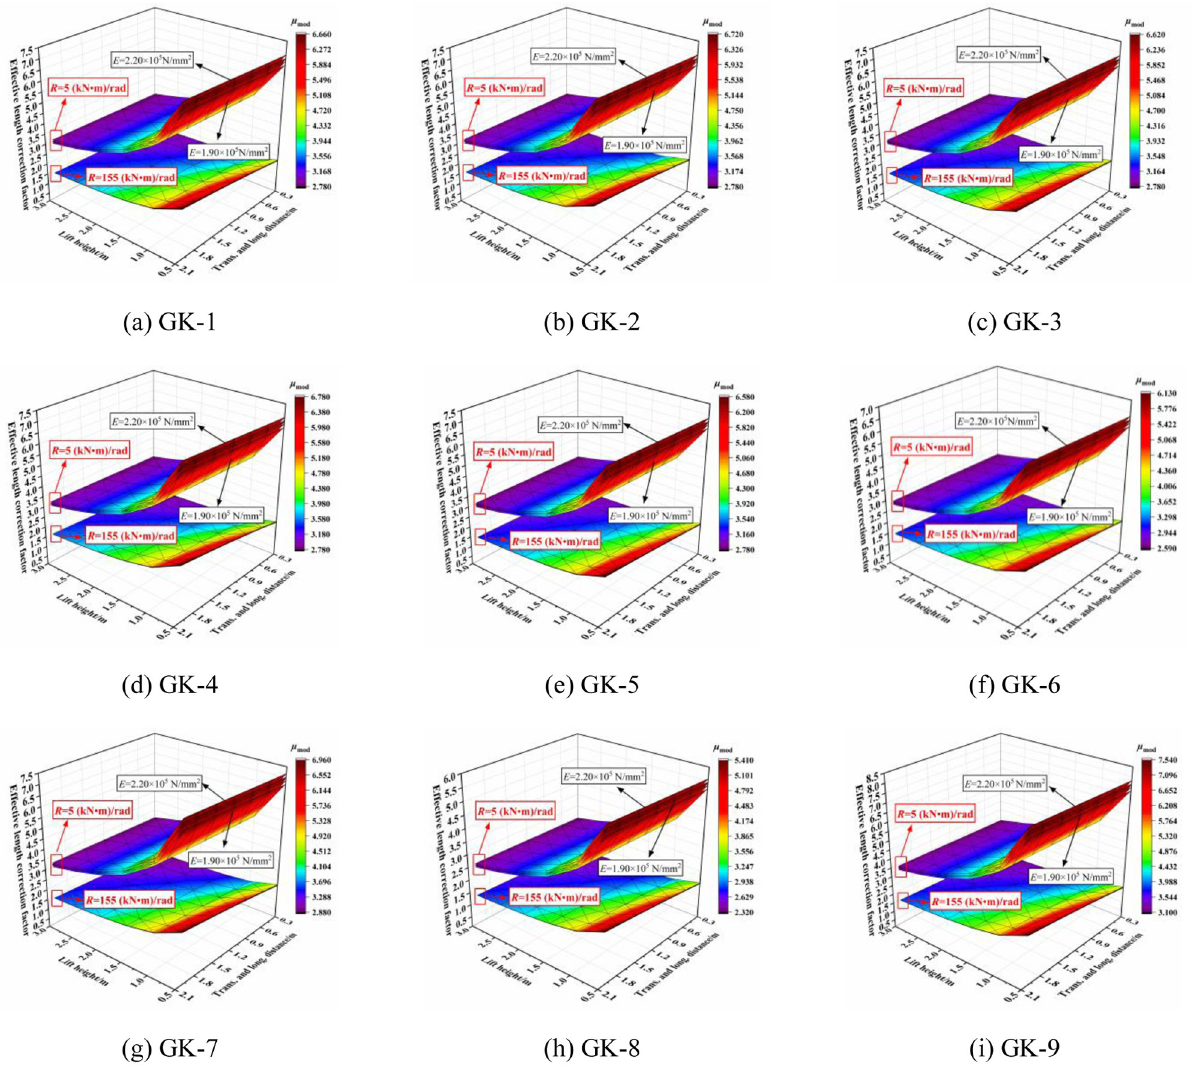
Fig 27. Three-dimensional diagrams of the influence of elastic modulus on the effective length correction factor. (a) GK-1. (b) GK-2. (c) GK-3. (d) GK-4. (e) GK-5. (f) GK-6. (g) GK-7. (h) GK-8. (i) GK-9.